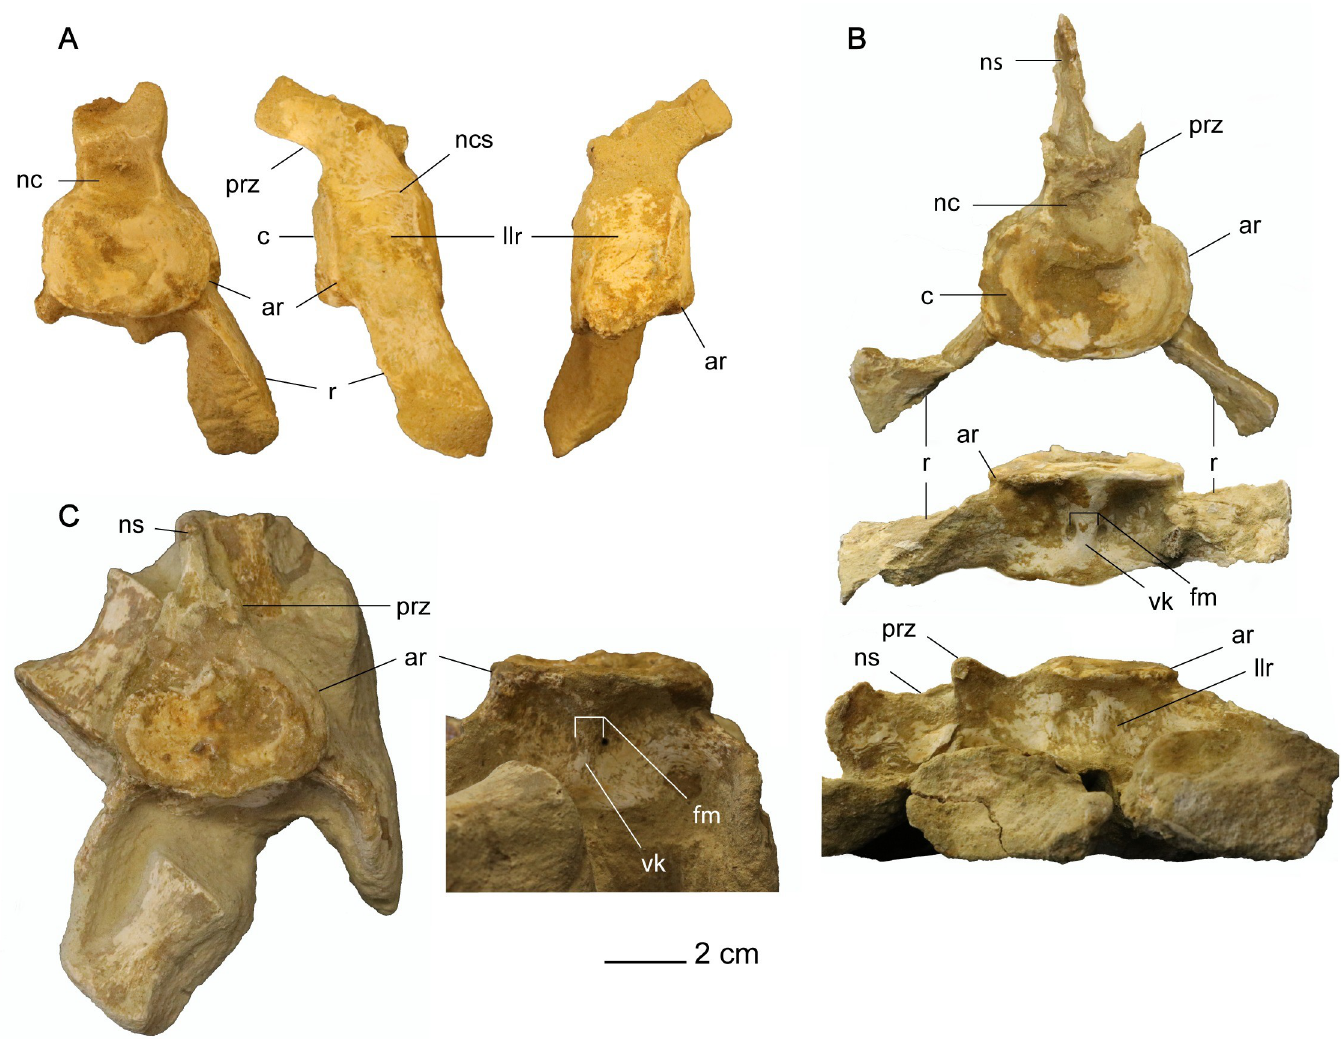
Fig 19. Anterior cervical vertebrae of Cardiocorax mukulu (MGUAN PA278). A. ‘Anterior cervical vertebra a’ in anterior, left lateral, and right lateral views (left to right) B. ‘Anterior cervical vertebra b’ in anterior, ventral, and right lateral views (top to bottom). C. ‘Anterior cervical vertebra d’ in anterior and ventral views (left to